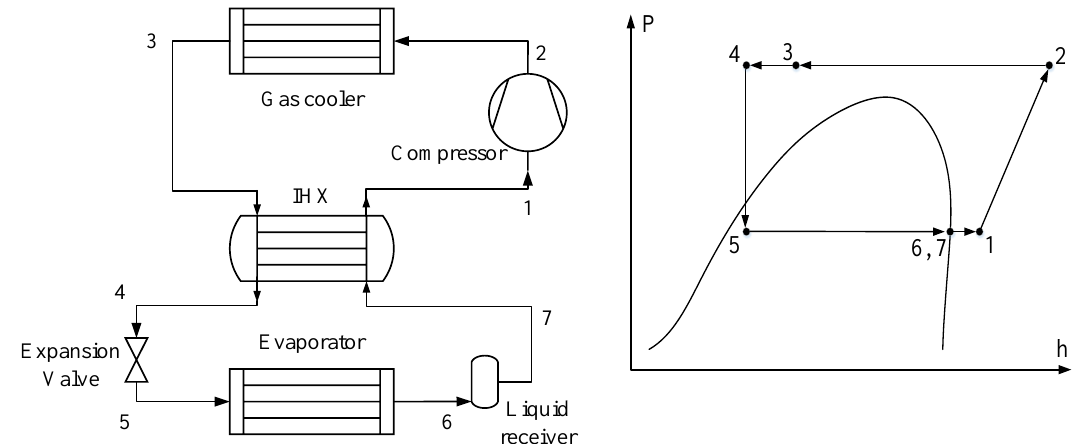
Figure 2. Schematic diagram of a transcritical CO 2 cycle with an internal heat exchanger (model 2: internal heat exchanger (IHX) cycle).